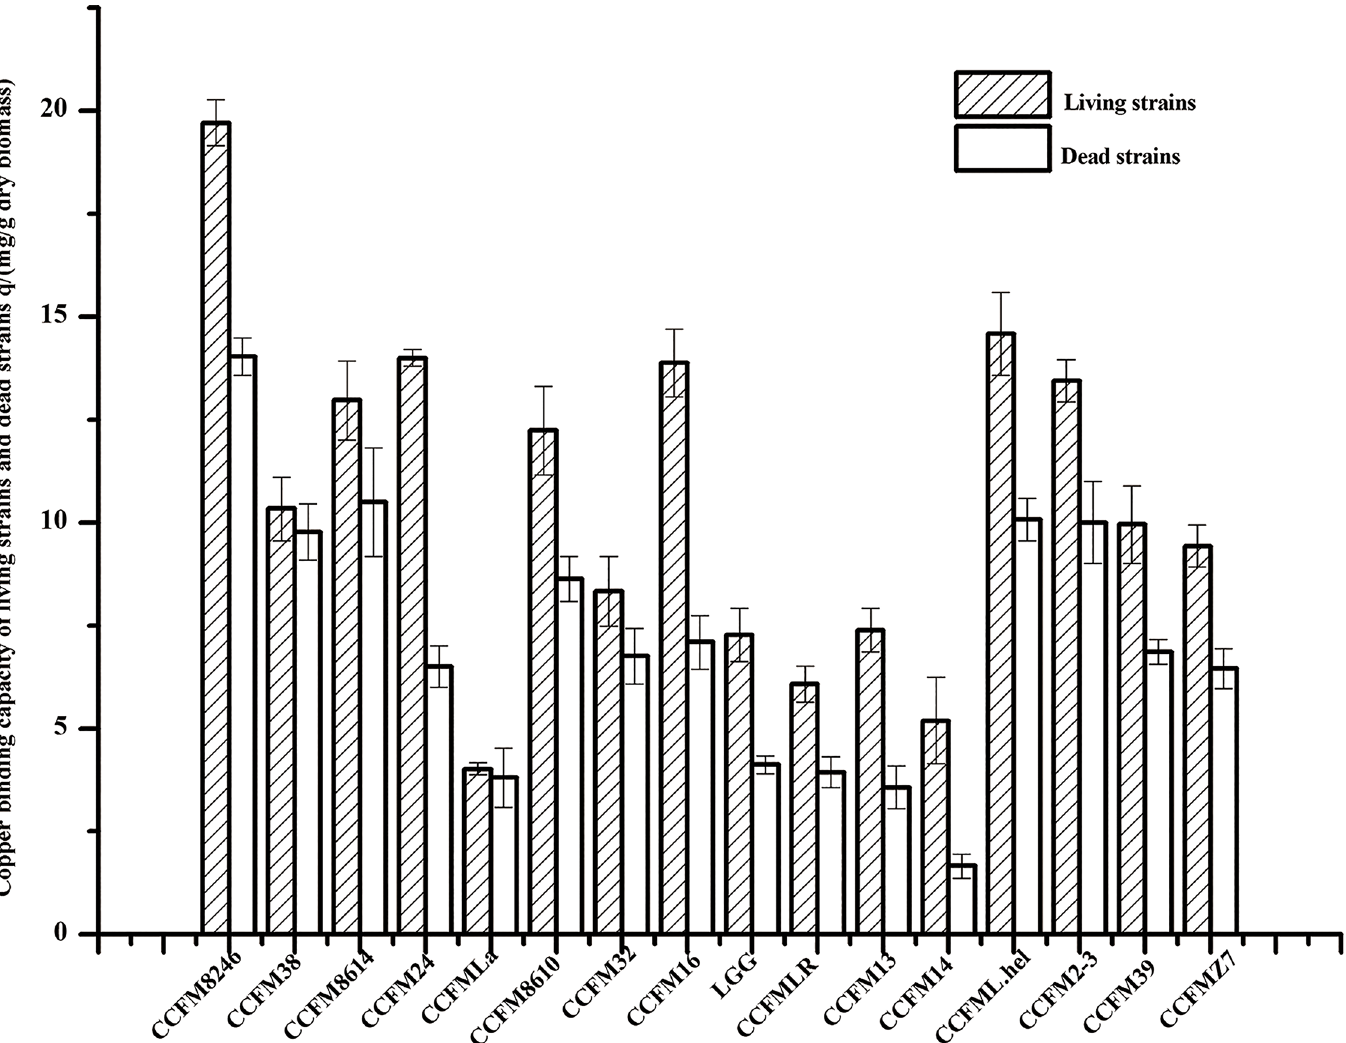
Fig 1. Copper binding capacity of bacterial strains. The average of three replicates and standard deviation are presented. CCFM8246, CCFM8614 and CCFM8610 are Lactobacillus plantarum . CCFM38 is Lactobacillus casei . CCFM24 is Lactobacillus bulgaricus . CCFMLa is Lactobacillus acidophilus . CCFM32 is Lactobacillus thermophilus . CCFM39 and CCFM16 are Bifidobacterium . LGG is L . rhamnosus GG. CCFMLR and CCFM13 are Lactobacillus reuteri . CCFM14 is Lactobacillus sake . CCFML.hel is Lactobacillus helveticus . CCFM2-3 is Lactobacillus delbrueckii . CCFMZ7 is Lactobacillus fermentum